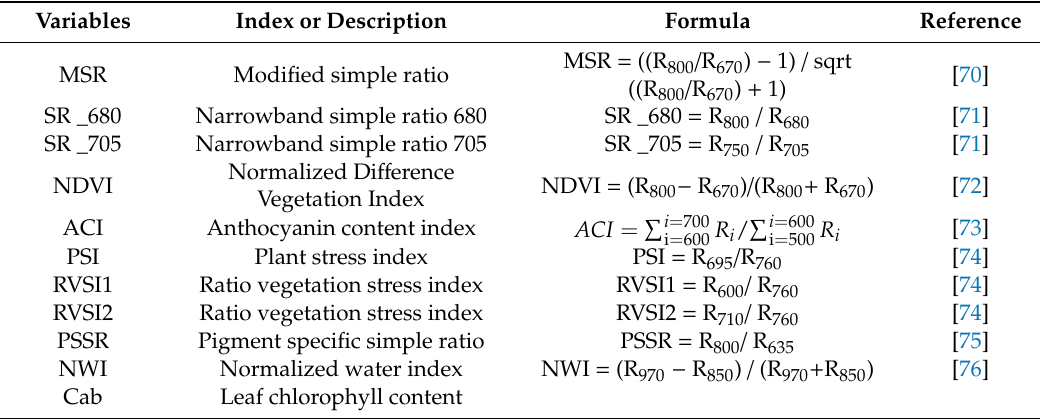
Table 3. Features selection of hyperspectral